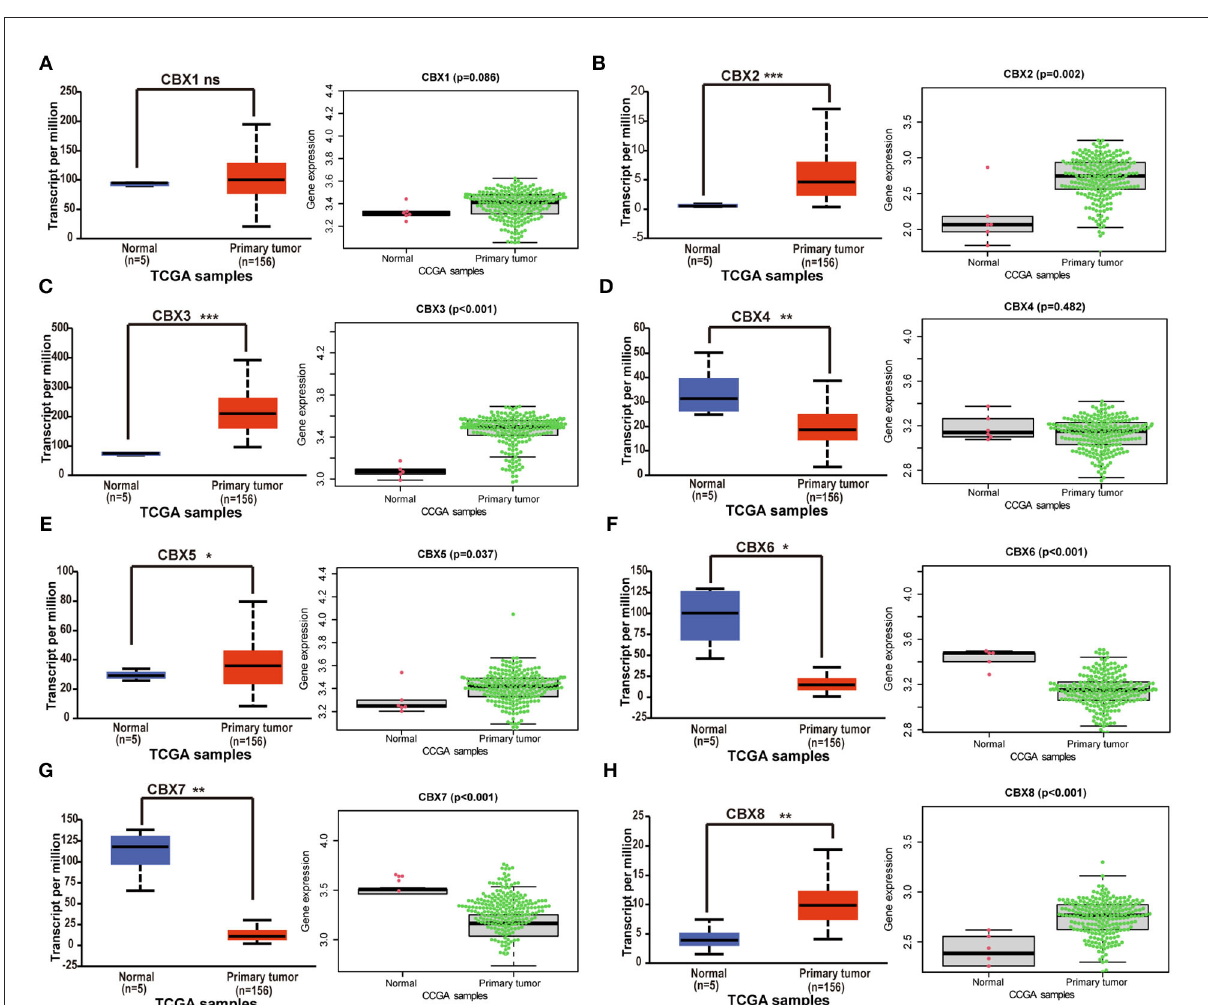
FIGURE2 The differential expressions of CBX family at mRNA level in TCGA and CGGA. (A-H) The mRNA expression difference of CBXs in GBM was analyzed in The Cancer Genome Atlas (TCGA) and the Chinese Glioma Genome Atlas (CGGA) databases. UALCAN provided 156 GBM samples for analysis (ns, no significance; * p < 0.05, ** p < 0.01, *** p < 0.001). 218 GBM samples from CGGA were downloaded and analyzed via “survminer” R package. The p -value was set at